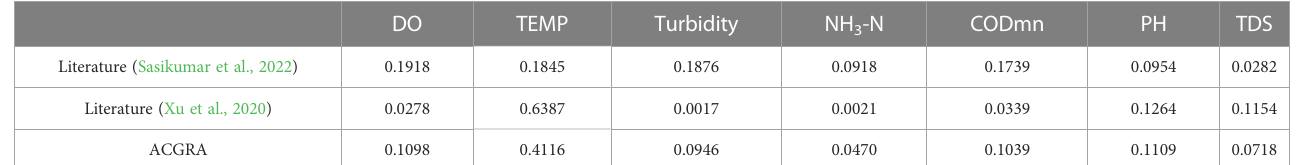
TABLE 4 Correlation of water quality